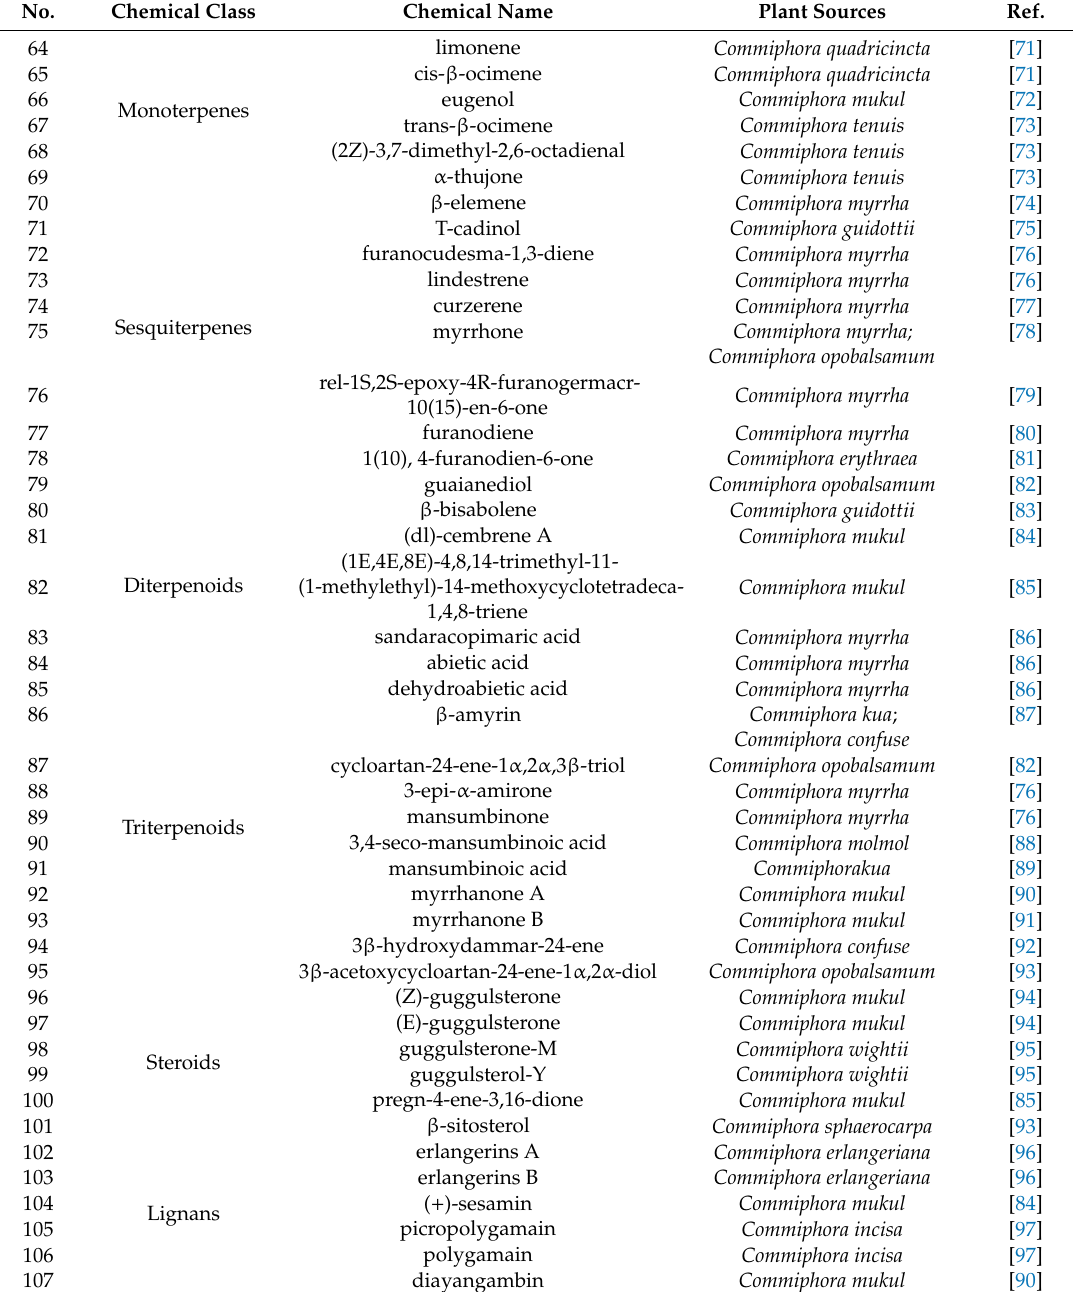
Table 3. The main chemical constituents and plant sources of